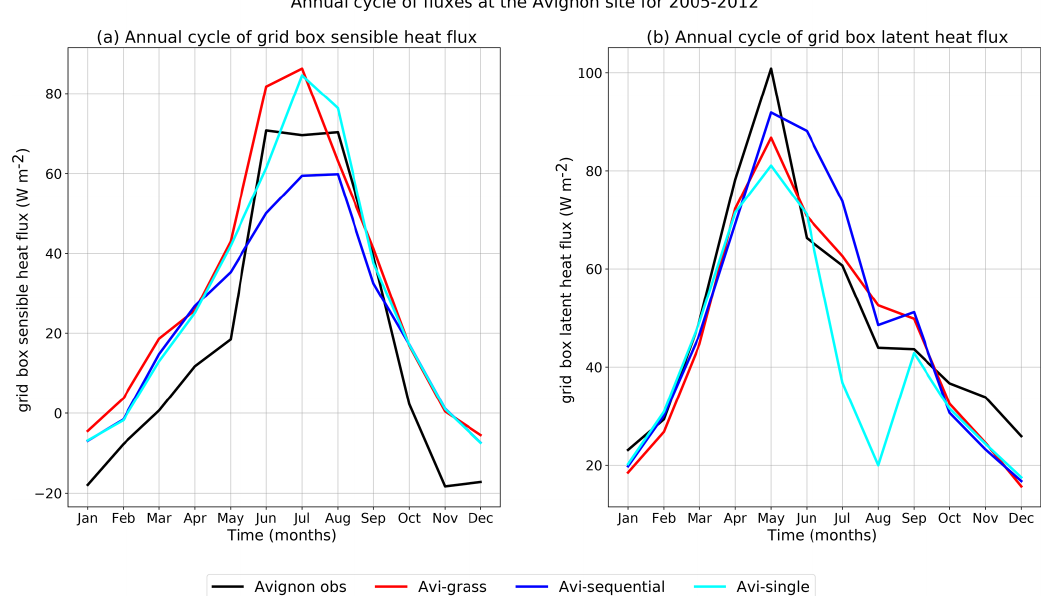
Figure A2. Annual cycle of H (a) and LE (b) compared with observations (black line) at the Avignon site between 2005 and 2013. Annual cycles for the simulations are also shown: Avi-grass (red line), Avi-sequential (blue line) and Avi-single (cyan line). Geosci. Model Dev., 14, 437–471,